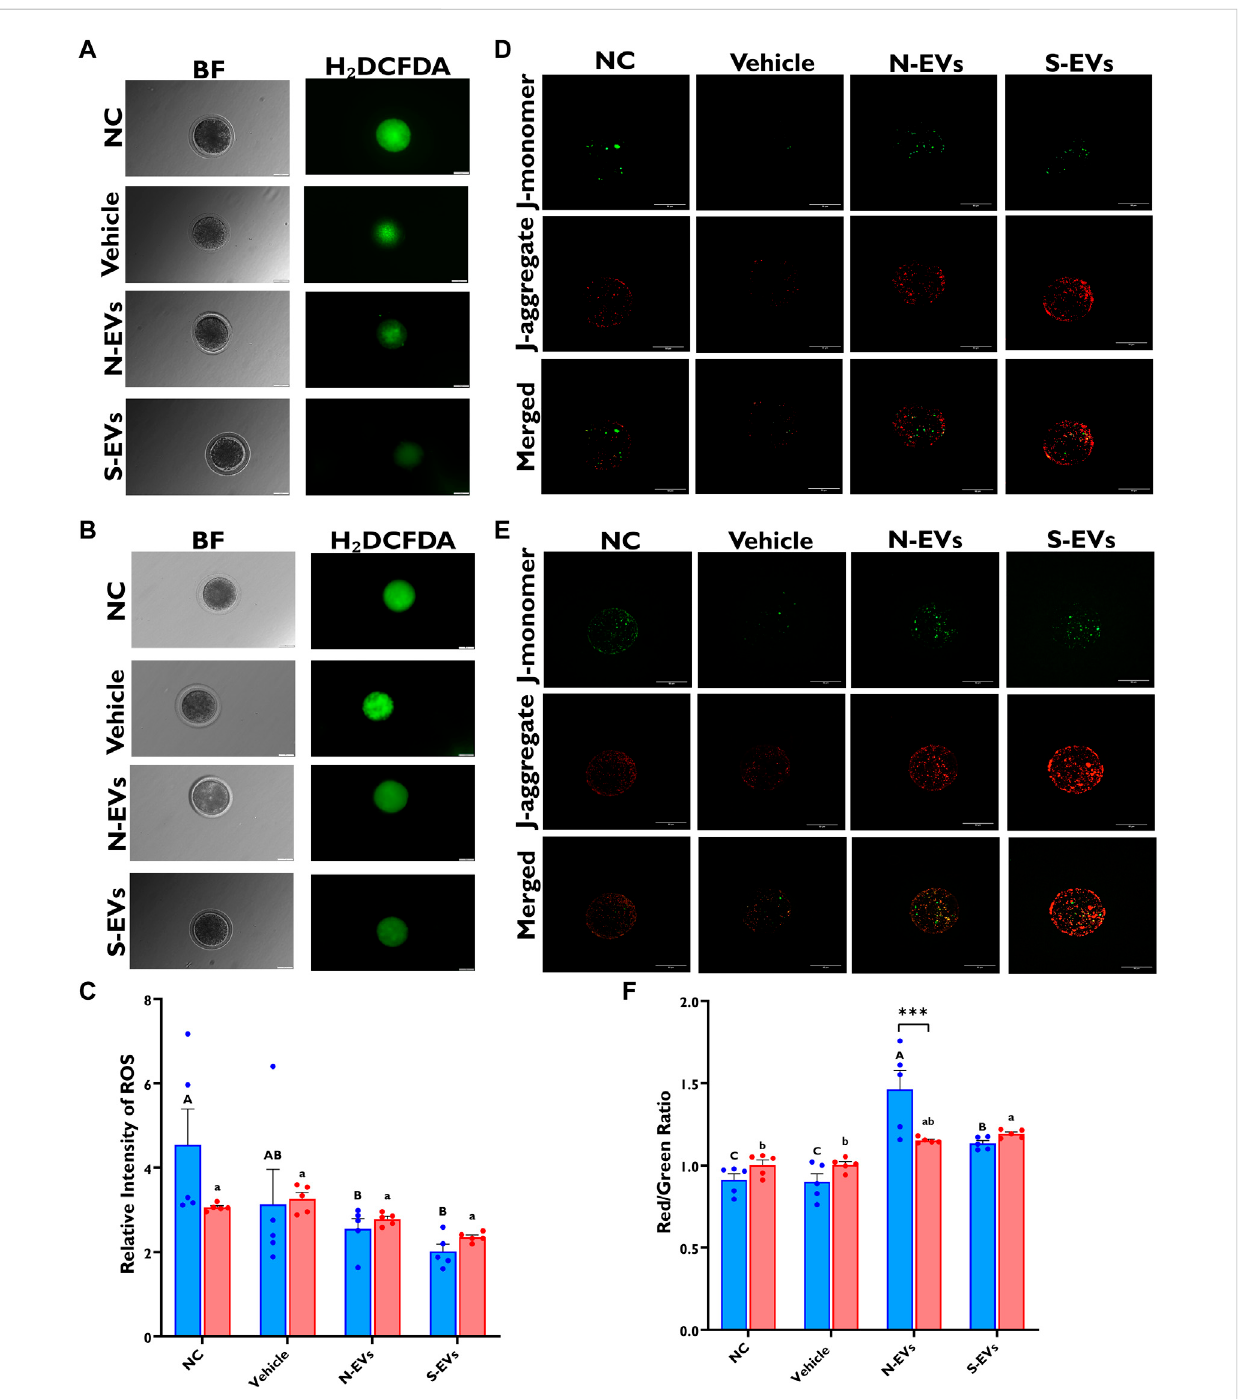
FIGURE 5 The bene fi cial effects of GC-EVs on oocyte function under in vitro normal physiological (38.5 ° C; blue) and HS (41 ° C; red) conditions. Fluorescence imagesof invitro maturedbovineoocytestreatedwith2 ʹ ,7 ʹ -Dichloro fl uorescinDiacetate(H ₂ DCFDA)werecapturedforthemeasurementofintracellular ROS levels in single oocytes. Scale bar, 50 µM [38.5 ° C; (A) ] [41 ° C; (B) ]. Quanti fi cation of the relative fl uorescence intensity in single oocytes were carried out in triplicates (total = of 15 – 50 oocytes per treatment) (C) . Fluorescence images of in vitro matured bovine oocytes treated with 5,5 ′ ,6,6 ′ - tetrachloro-1,1 ′ ,3,3 ′ tetraethylbenzimidazolylcarbocynanine iodide (JC-1) for the measurement of MMP ( Δ Ψ m), an indicator of mitochondrial activity in single oocytes. Scale bar, 50 µM [38.5 ° C; (D) ] [41 ° C; (E) ]. Quanti fi cation of the relative fl uorescence intensity (red/green ratio) in single oocytes were carried out in duplicates (total = of 12 – 22 oocytes per treatment) (F) . Data among treatments represent the mean ± SEM and the differences between means were analyzed using Two-way ANOVA followed by Tukey ’ s Multiple Comparisons Test. Bars with different letters (38.5 ° C; uppercase) (41 ° C; lowercase) indicate statistically signi fi cant differences of at least ( p < 0.05) between treatments under the same culture conditions, while (*) indicate statistical differences between the same treatment under different culture environments during IVM (*** p <